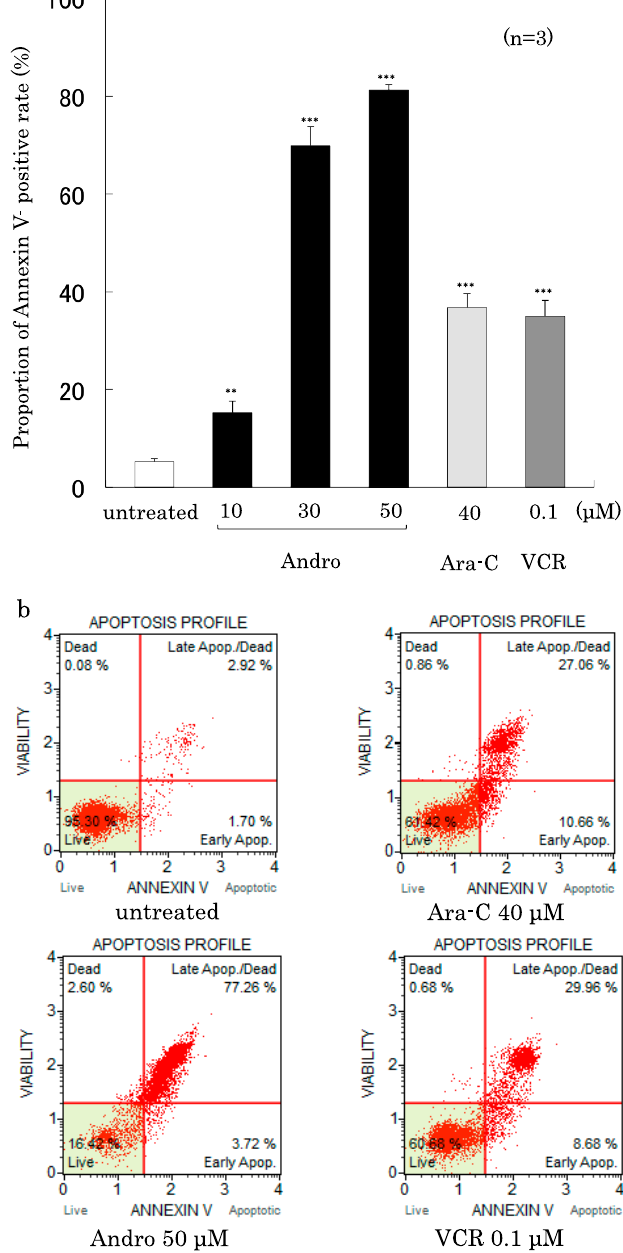
Figure 4 Effects of Andro on annexinV expression of the cells. a: Histogram of proportion of annexin V-positive cells. The annexin V- positive proportion was shown after 24 h treatment with Andro, Ara-C or VCR, using the Muse Cell Analyzer. The annexin V-positive proportion indicates the total of annexin V positive cells with 7-AAD negative and 7- AAD positive cells. Results are expressed as mean±SD of three independent experiments (***P<0.001, **P<0.01, as compared with untreated cells). b: Dot plots of Annexin V positive cells. Annexin V-positive cells after treatment with Andro, Ara-C and VCR for 24 h were shown at dot plots using Muse Cell Analyzer. The x-axis indicates the annexin V-positive cells, and the y-axis indicates 7-AAD